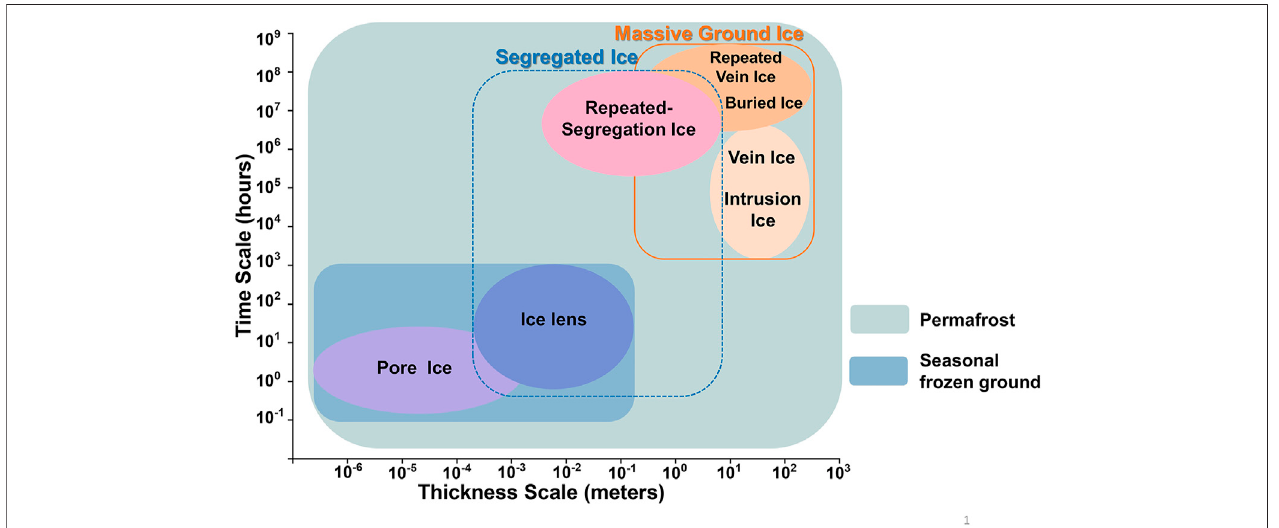
FIGURE 1 | The types of ice in frozen soil range from the pore size to the massive ground ice size at the spatial scale, and their formation ranges from sub-daily to centennialatthetemporalscale.Thestudyfocusesonthesegregatediceandwatermigrationwithmediumandminorscales(bluedottedline),whichexistinpermafrost and seasonally frozen ground.